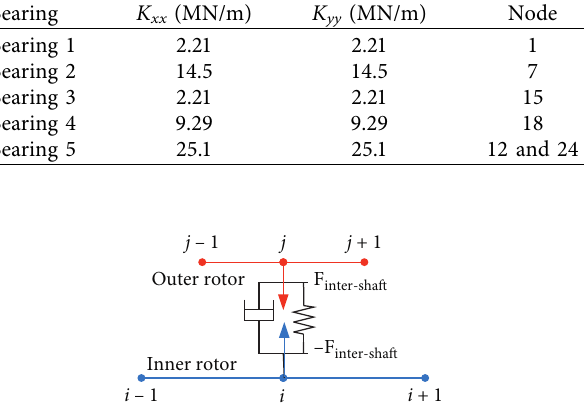
Figure 4: Force analysis diagram of the intershaft bearing.